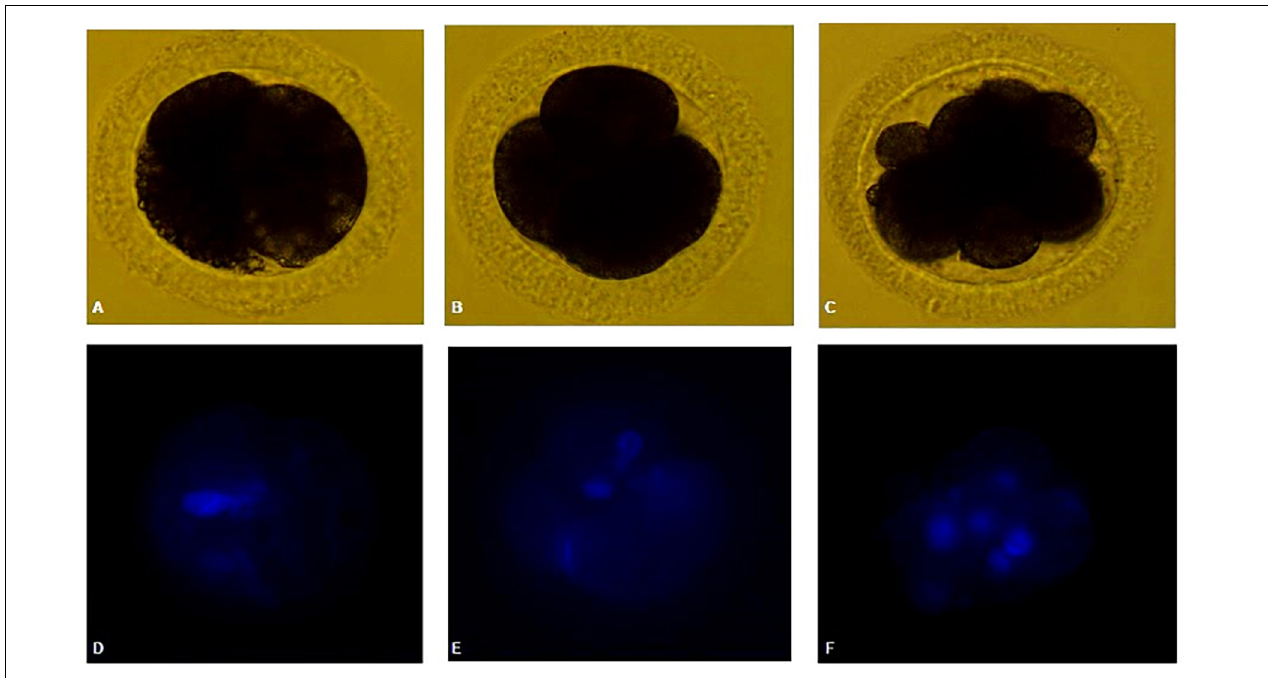
FIGURE 4 | (A,D) Canine oocyte at 2-cell stage. (B,E) Canine oocyte at four-cell stage. (C,F) Canine oocyte at eight-cell stage. Parthenogenetic embryos visualized by bright field and Hoechst